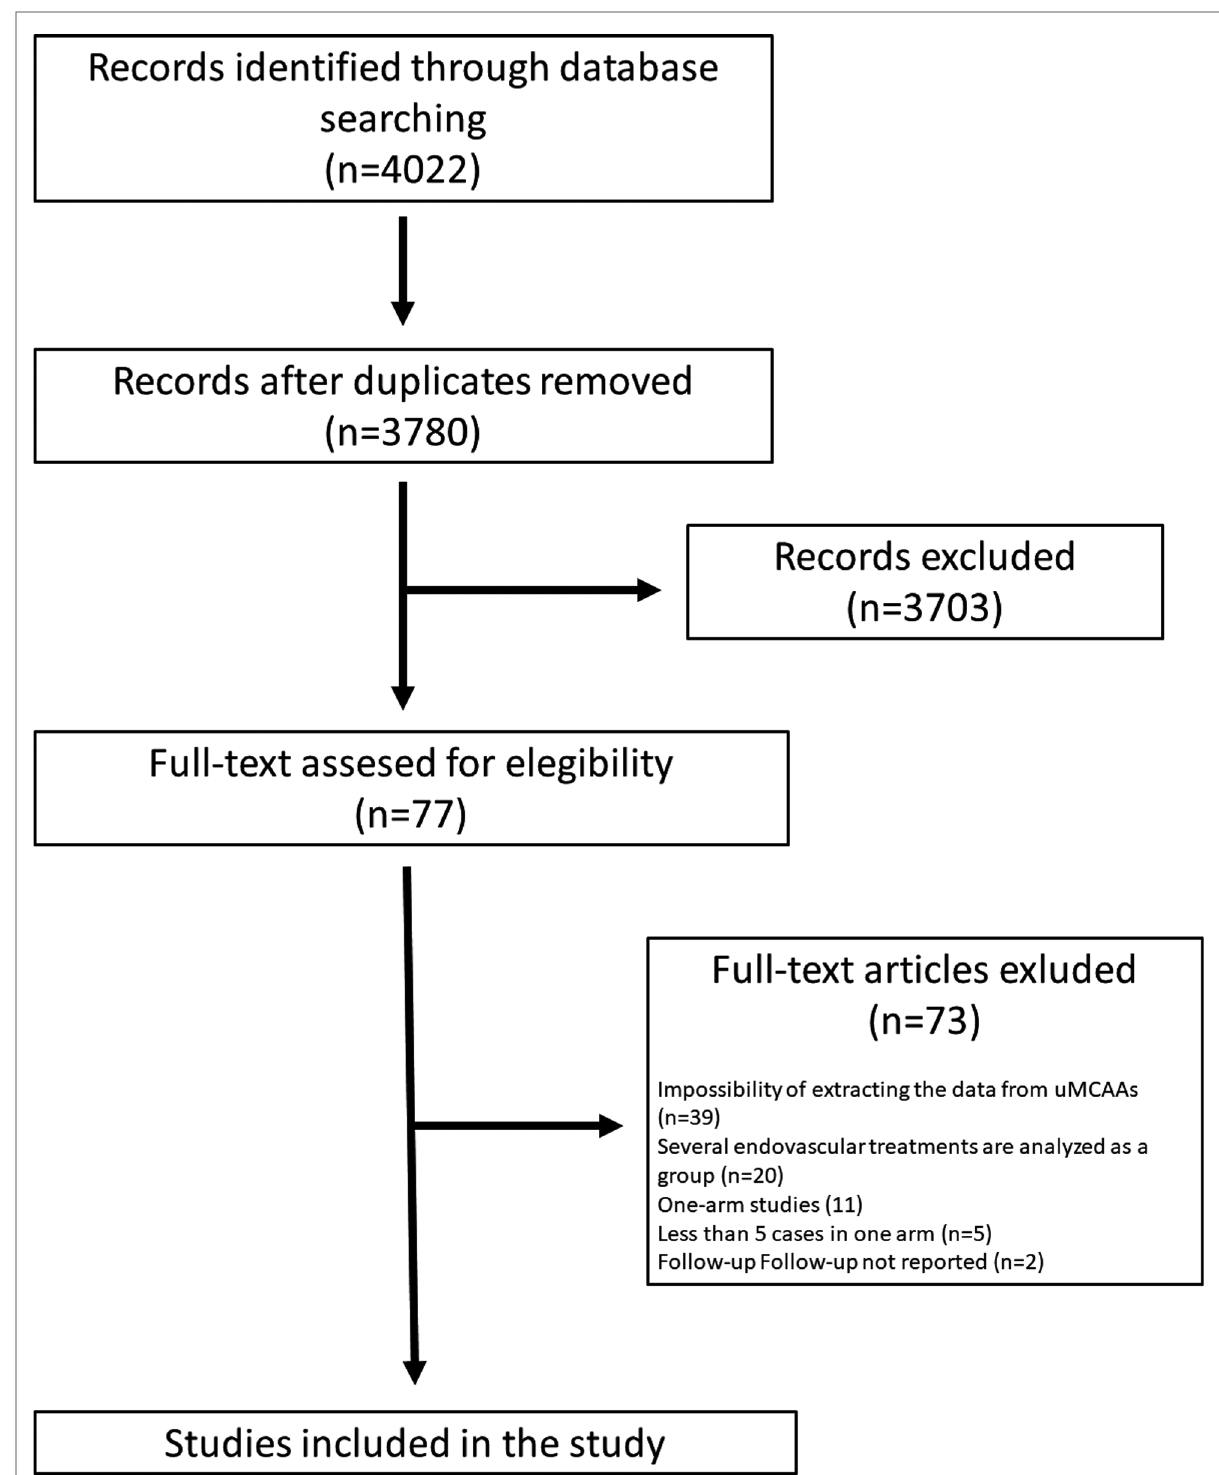
FIGURE 2 Flow diagram showing the fl ow of information through the different phases of the systematic